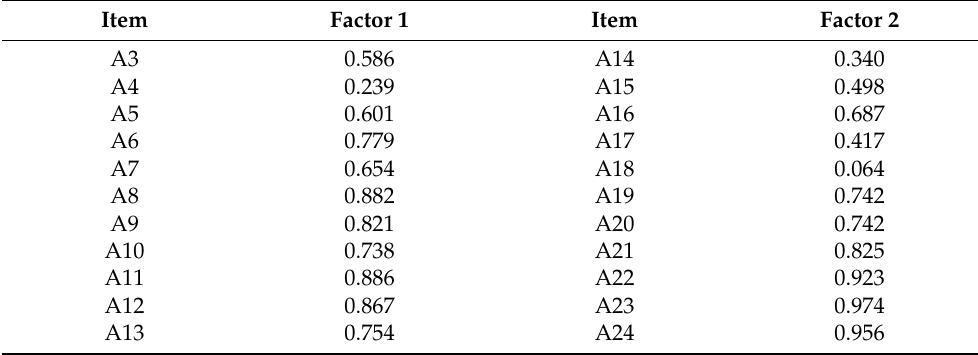
Table 4. Pattern matrix of the AAAQ with two factors.